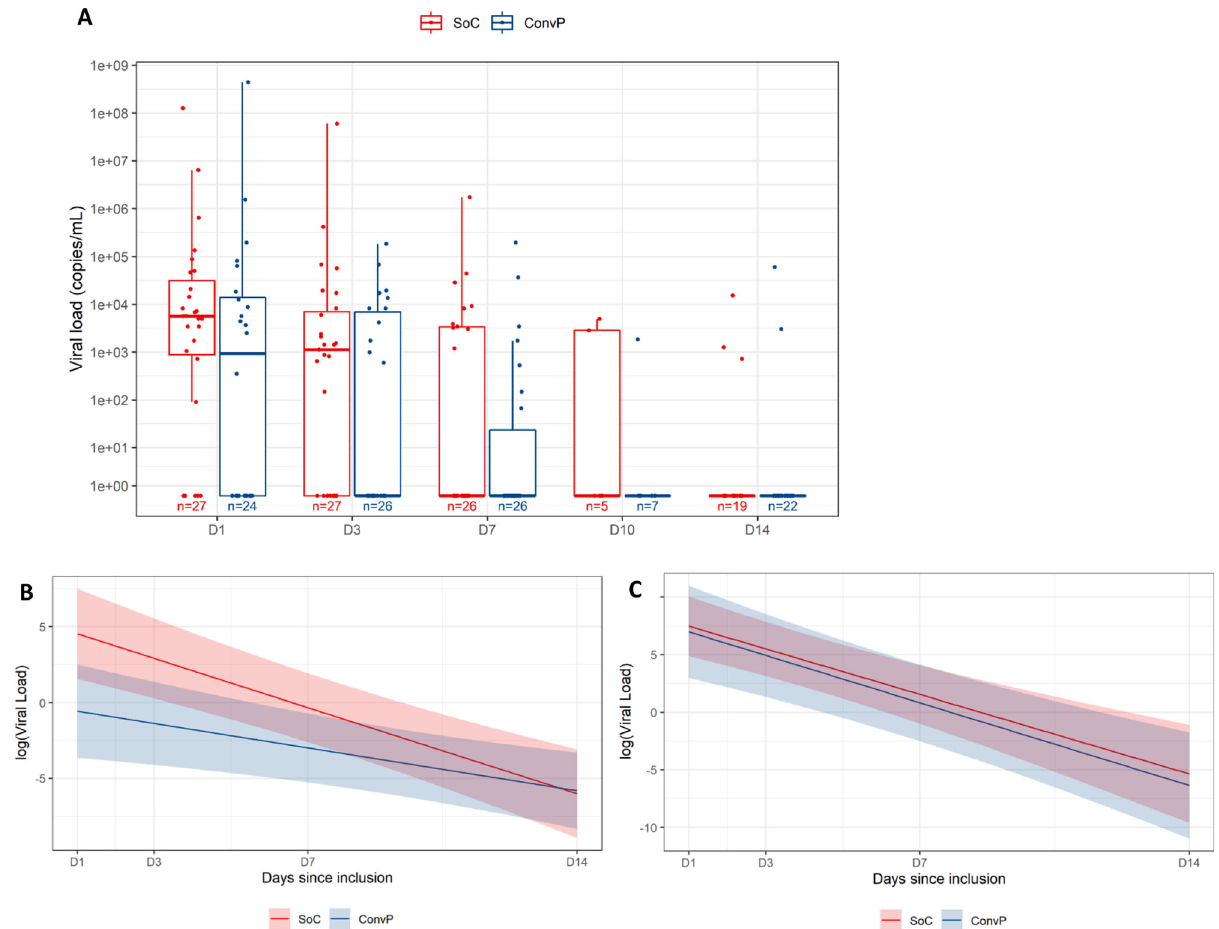
Fig. 8 SARS-CoV-2 (predicted) viral load in patients. A SARS-CoV-2 viral load in patients. B Predicted SARS-CoV-2 viral load in patients. C Predicted SARS-CoV-2 viral load in selected patients. SARS-CoV-2 viral load (copies/mL) measured by RT-PCR from nasopharyngeal swabs of COVID-19 patients (standard of care: red; convalescent plasma: blue) at enrollment (day 1) and day 3, day 7, day 10, and day 14 after enrollment. Box plots indicate median (middle line), 25th, 75th percentile (box), and 5th and 95th percentile (whiskers), as well as outliers (single points). Predicted evolution mean (solid line) and 95% CI (shaded area) of SARS-CoV-2 log(Viral Load) in log(copies/ml) per day since enrollment ( D = 1) for COVID-19 patients (standard of care: red; convalescent plasma: blue). Predicted evolution mean (solid line) and 95% CI (shaded area) of absolute log(Viral Load) in log(copies/ml) per day since enrollment ( D = 1) for COVID-19 patients (standard of care: red; convalescent plasma: blue) excluding subjects who had SARS-CoV-2 viral load equal to zero at day 1 of